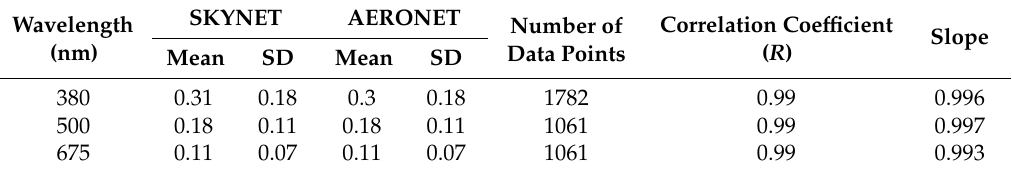
Figure 2. (top panel) Comparison between sky radiometer network (SKYNET) and aerosol robotic network (AERONET) aerosol optical thickness (AOT values) at ( a ) 380, ( b ) 500, and ( c ) 675 nm. The data with cloud flag 0 in both datasets were plotted. The solid black lines in ( a ), ( b ), and ( c ) indicate the 1:1 line. (bottom panel) ( d ) The difference between the SKYNET and AERONET AOT values at 380, 500, and 675 nm was plotted as a function of the SKYNET AOT values at the respective wavelengths. Table 6. Summary statistics of the comparison between SKYNET and AERONET AOT at 380 nm at the Chiba site.